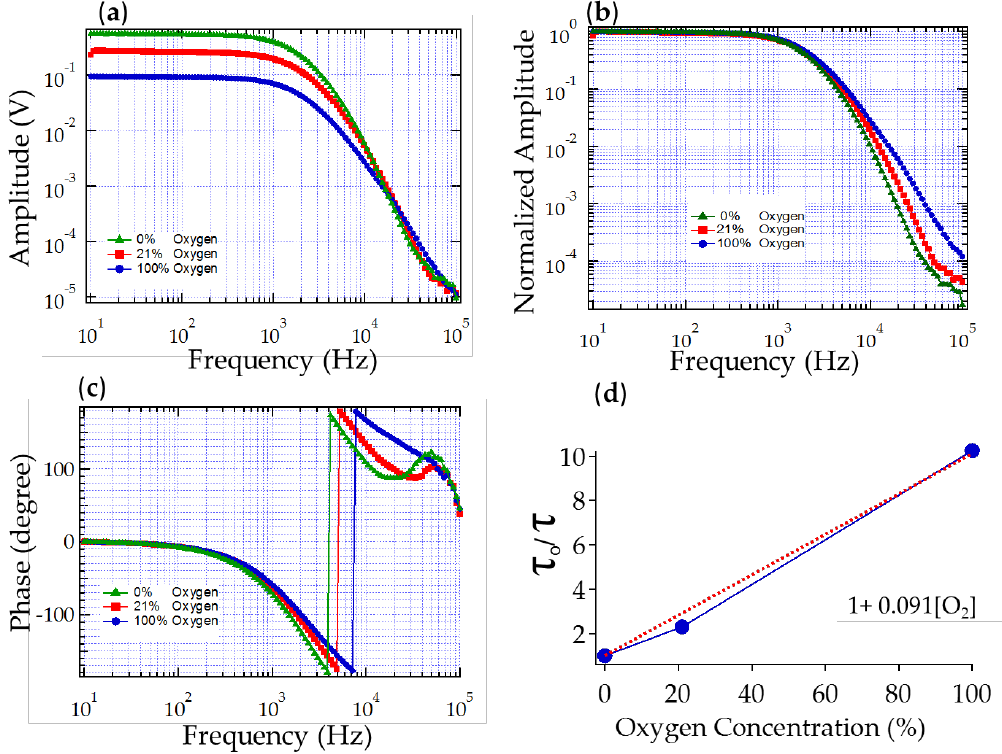
Figure S2. Spectral characterization of the oxygen sensing microchambers. ( a ) Amplitude was measured in V for three oxygen concentrations; ( b ) Normalized amplitude vs. frequency; ( c ) The phase vs. frequency behavior. The lock-in SR830 displays phase output from −180° to 180° hence the jump at around 3 kHz; ( d ) Due to a considerable difference in the phase shift, we chose 10 kHz as the reference frequency and calculate the phosphorescent lifetimes from the phase readouts. The plot of τ o / τ exhibits a linear Stern-Vollmer relationship. Our measured lifetime for 0%, 21%, 100% O 2 are 43.7 µ s, 19.0 µ s, and 4.26 µ s, respectively. All of these values are consistent with what have previously been reported [16,17].